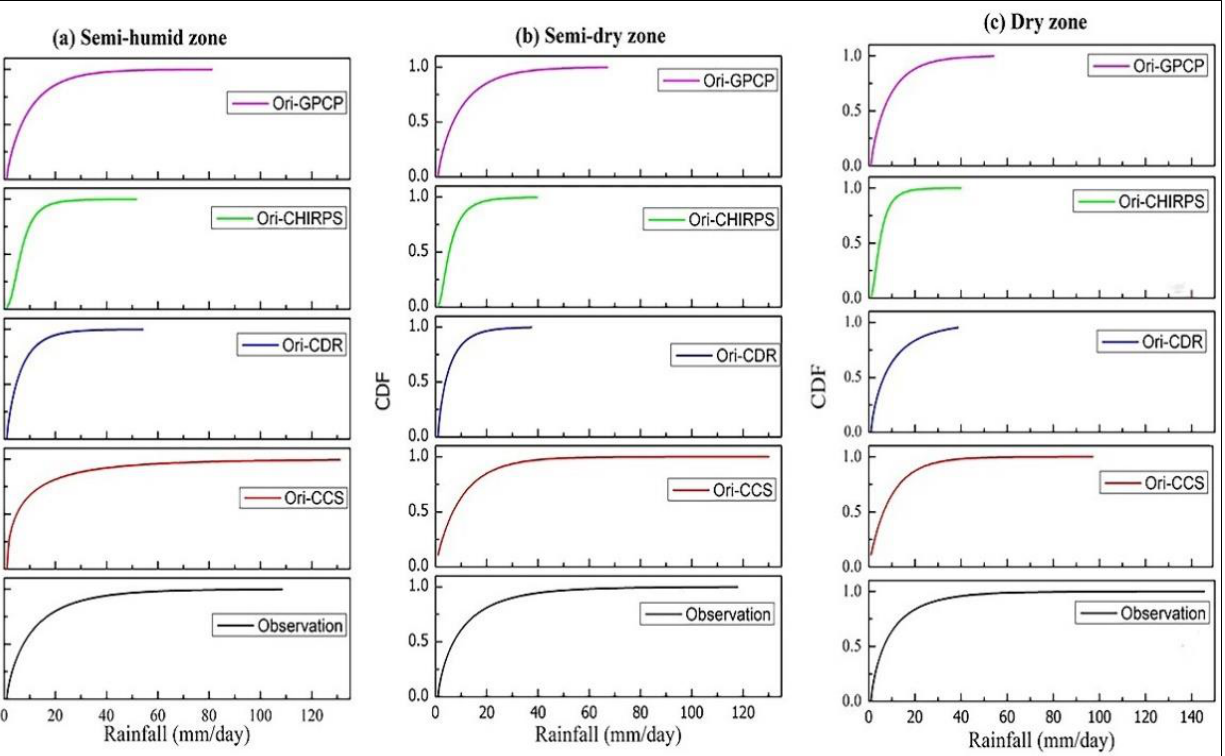
Figure 3. Seasonal (wet season) CDFs of daily gauge and Ori-CCS, Ori-CDR, Ori-CHIRS, and Ori-GPCP: ( a ) semi-humid zone, ( b ) semi-dry, and ( c ) dry zone.